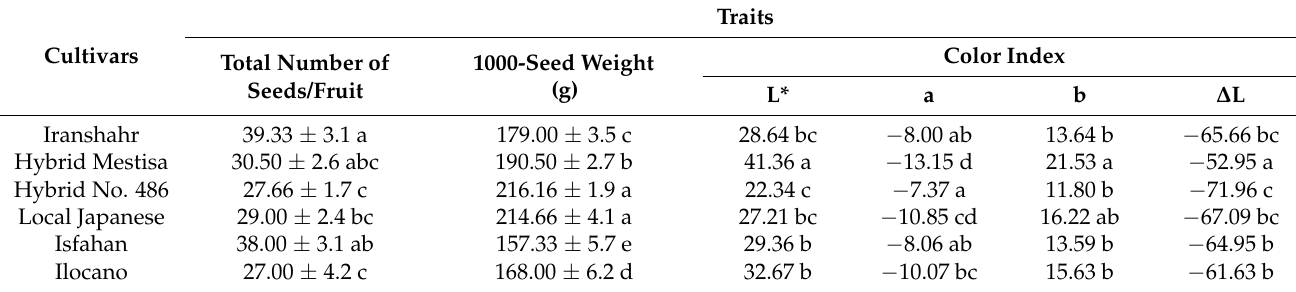
Means (three replications) in each column, followed by at least one letter in common are not significantly different at the 5% probability level using Tukey’s test. *CIELAB color space also referred to as L*a*b* and ∆ L are color indices defined by the International Commission on Illumination (abbreviated CIE) in